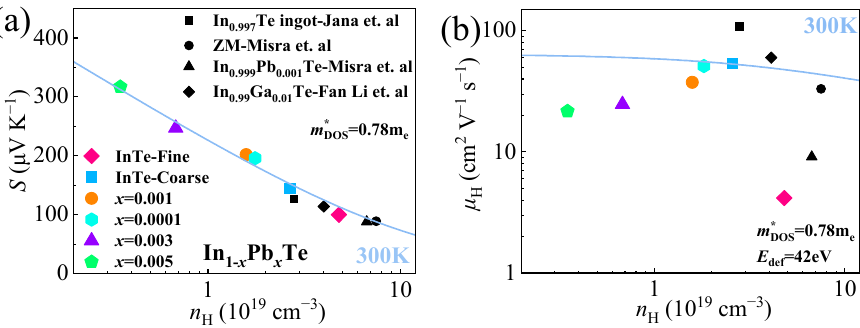
Figure 4. Room temperature Seebeck coefficient ( a ) and carrier mobility ( b ) versus the carrier concentration for the samples studied herein in comparison with the data in literature [15,16,21,29]. The sieved coarse In 1- x Pb x Te ( x = 0, 0.0001, 0.001, 0.003, 0.005) with a high texture de-